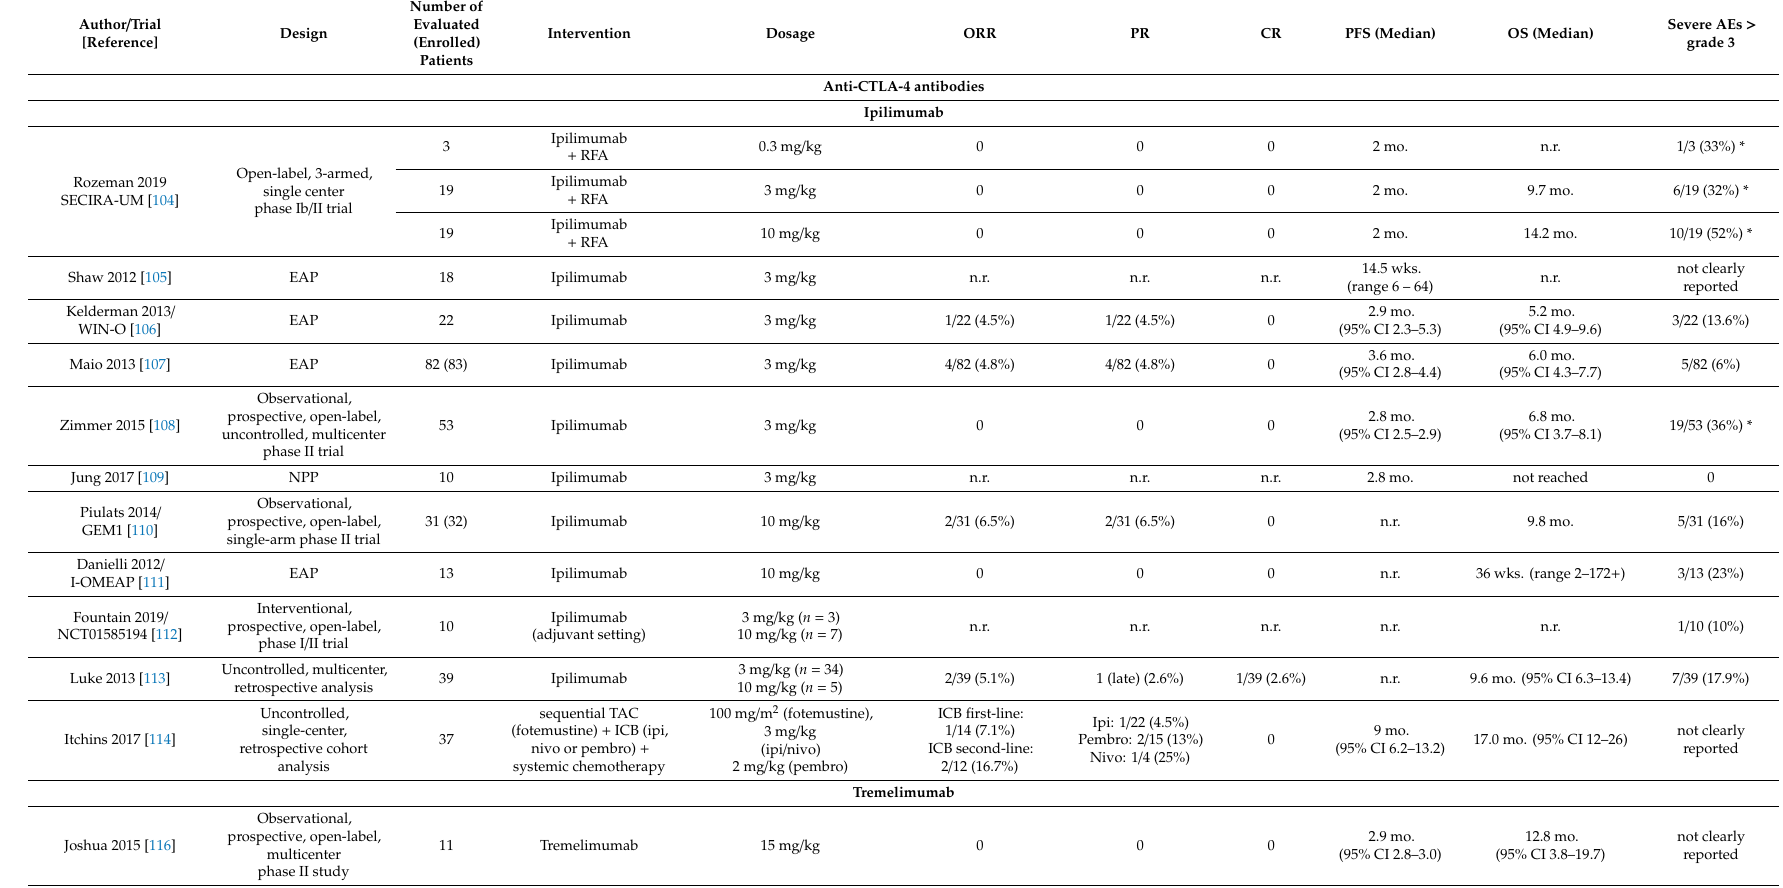
Table 1. Studies investigating immune checkpoint blockade for UM